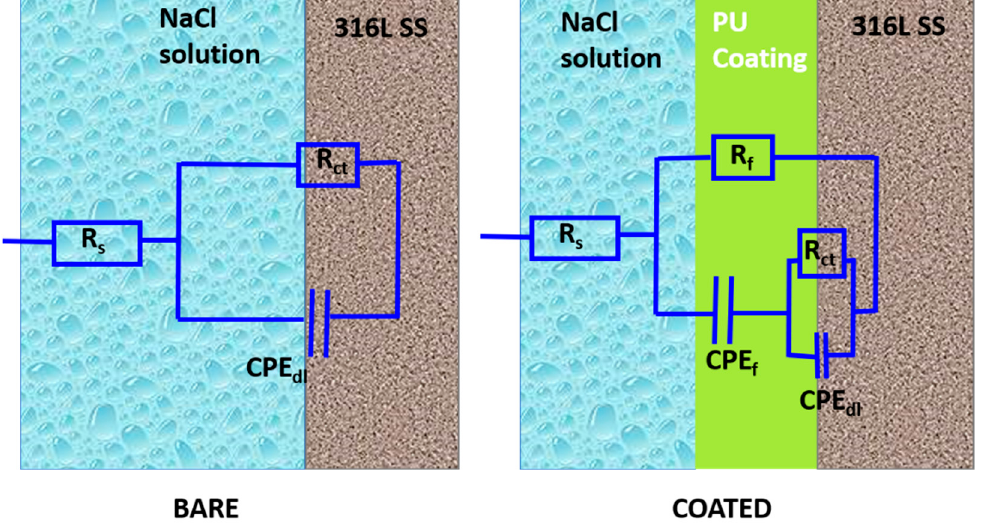
Figure 10. EIS circuit models for the bare and coated specimens. Table 4. EIS parameters of uncoated and coated 316L SS specimens in 3.5% NaCl